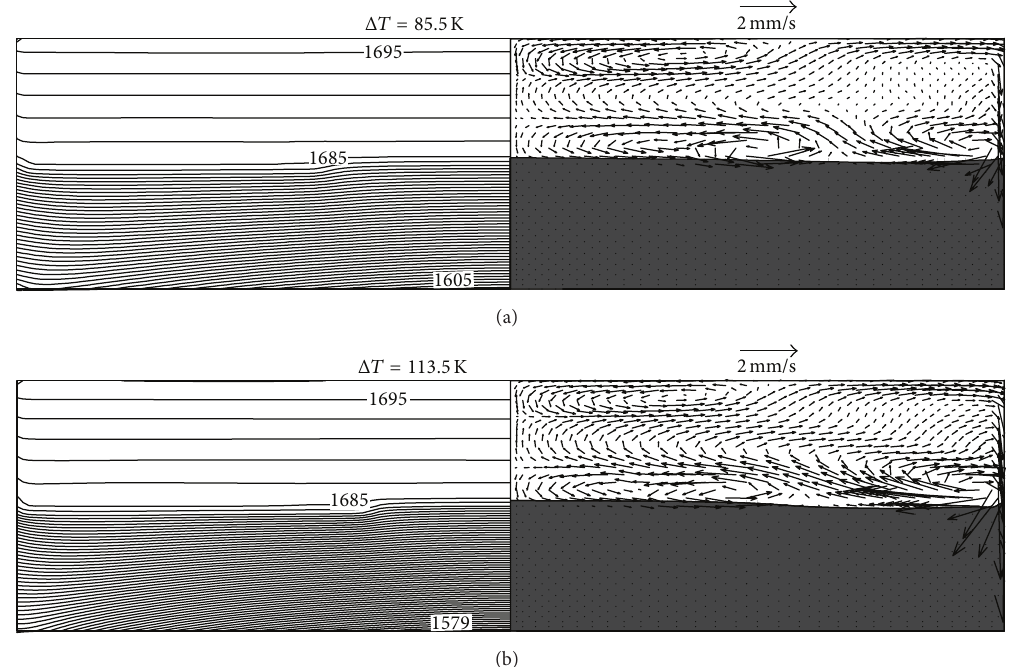
Figure 5: Temperature distribution (left, 2 K between isotherms), velocity vector, and melt-crystal interface (right) in the silicon domain under 50% solidification for DS processes with different crucible thermal conductivities: (a) 2W/m ⋅ K; (b) 6W/m ⋅ K. Δ𝑇 is the temperature difference along the axis in crystal